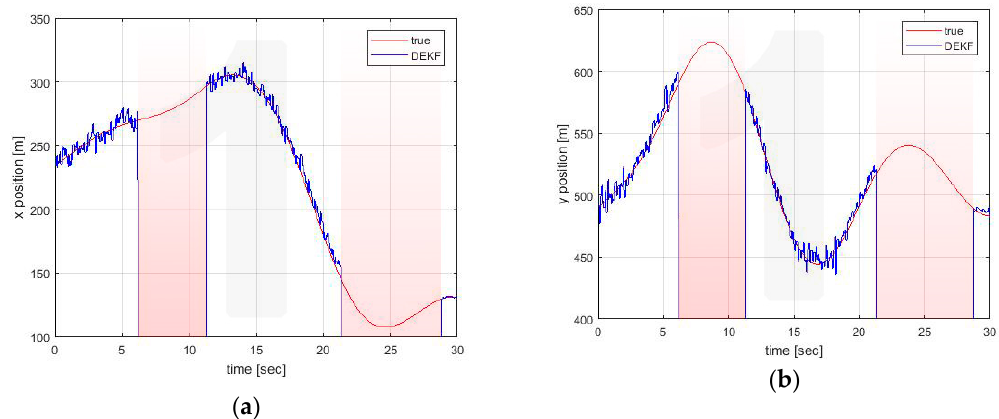
Figure 8. Position estimation performed by Vehicle 4 on its own position ( a ) x axis ( b ) y axis.